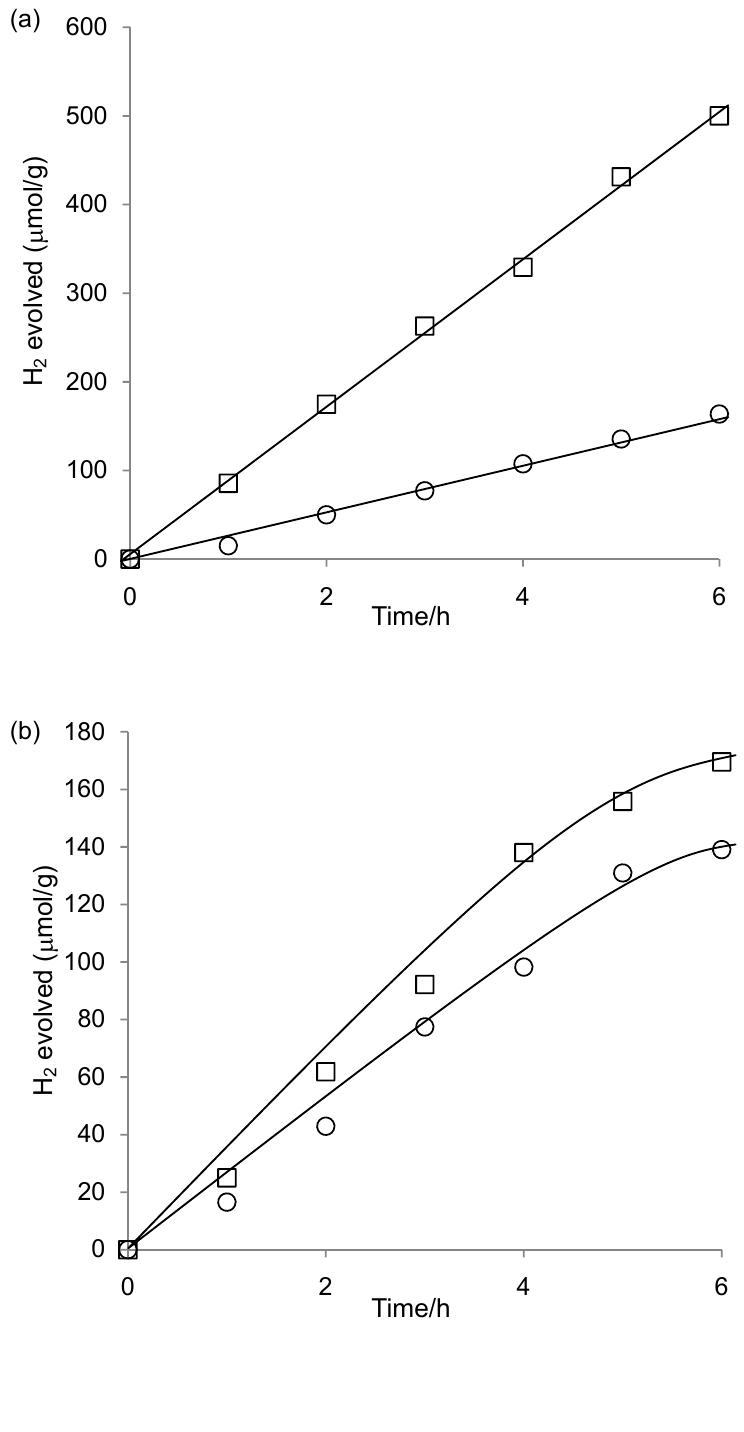
Figure 7. Time course for H evolution catalyzed by (a) 2 -Cs-TiO 2 2 -Cs-TiO (2.3) under light irradiation ( ≥ 400 nm). The first and second runs are represented 2 by circles ( ○ ) and squares ( □ ), respectively. Reaction conditions: see Table